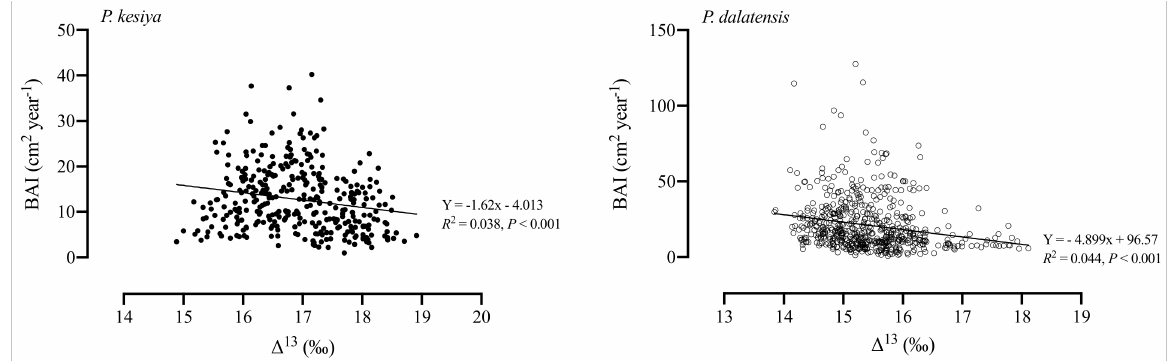
Figure 6. Correlation between the basal area increment (BAI; 1900–2013) of P. kesiya ( n = 340), P. dalatensis ( n = 575) and ∆ 13 C) of the respective tree rings. Solid line indicates the 13 C discrimination against atmospheric CO 2 (